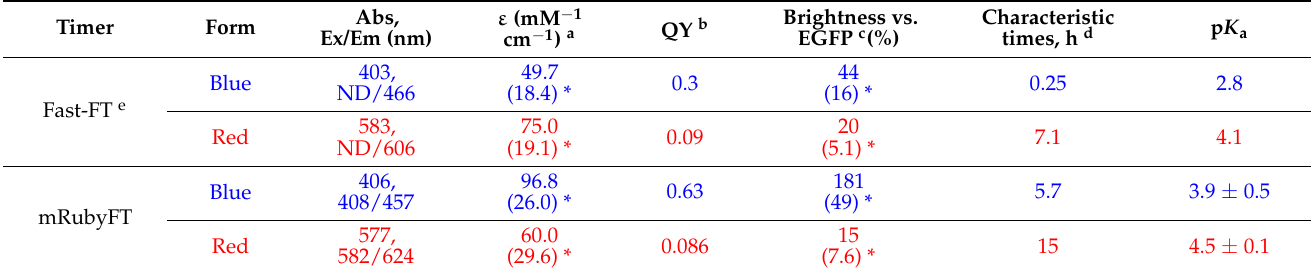
Table 1. In vitro properties of the purified blue-to-red timer mRubyFT. a —extinction coefficients for red forms were determined by alkaline denaturation method or relative to the absorption at 280 nm (*); extinction coefficients for blue forms were determined by acid denaturation method or relative to the absorption at 280 nm (*). b —quantum yields (QYs) for blue and red forms were determined relative to mTagBFP2 (QY of 0.64) and mCherry (QY of 0.22), respectively. c —brightness was calculated as a product of quantum yield and extinction coefficient relative to the brightness of EGFP protein (QY of 0.6 and extinction coefficient of 56,000 M − 1 cm − 1 ). d —characteristic times for the blue- and red forms of Fast-FT and mRubyFT correspond to the maximum of the blue fluorescence and half of the red fluorescence, respectively, at 37 ◦ C. e —data from references [1,4]. The blue and red font color reflects the fluorescence color of the respective blue and red